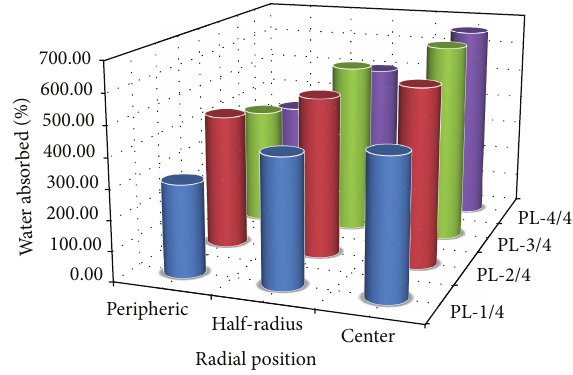
Figure 2: Summary of the percentage of water absorbed of Raffia vinifera fibres along the